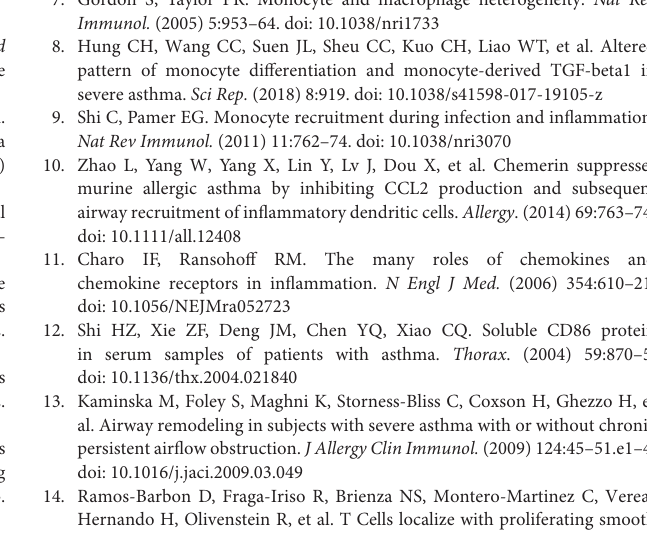
Figure S1 | Monocyte do not cross epithelium in a short migration assay. Illustration of monocyte migration through a reconstituted bronchial epithelium evaluated by micro-OCT. (A) At T 0min, the epithelium is inverted and neutrophils (white arrows) (B) or monocytes (C) are added on the upper chamber and set to migrate for 4h. (Scale bar = 100 µ m). Figure S2 | Chemokine expression in co-cultured epithelial cells after rhinovirus infection. Additional chemokines mRNA were quantified in epithelial cells by multiplex gene expression analysis. Data are presented as mean ± SEM values ( n = 3 per group, one-way ANOVA, Newman-Keuls multiple comparisons test, ∗ P < 0.05; ∗∗ P < 0.01; ∗∗∗ P < 0.001; ∗∗∗∗ P < 0.0001). Figure S3 | Asthmatic bronchial smooth muscle cell co-culture increases inflammation in epithelial cells after rhinovirus infection. (A) Cytokines and (B) rhinovirus-mediated genes were assessed in epithelial cells by multiplex gene expression analysis. Data are presented as mean ± SEM values ( n = 3 per group, one-way ANOVA, Newman-Keuls multiple comparisons test, ∗ P < 0.05; ∗∗ P <